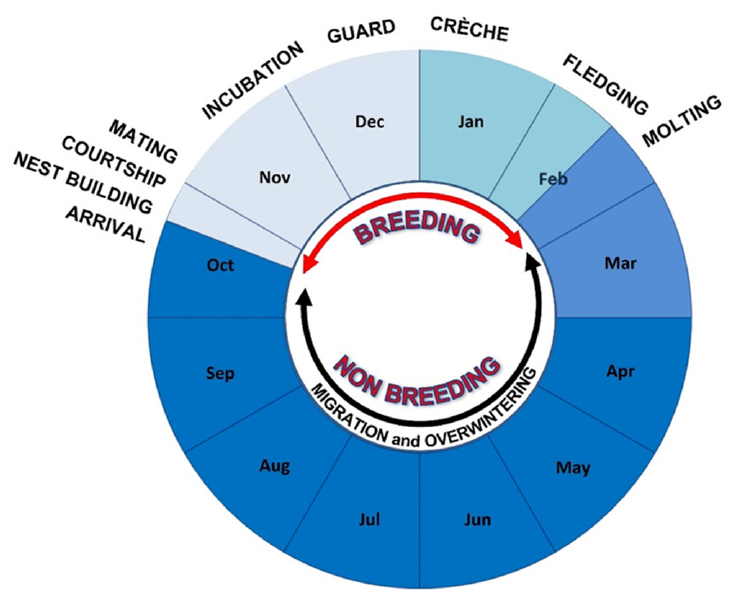
Figure 2. Adélie penguin annual cycle. Figure 2. Ad é lie penguin annual